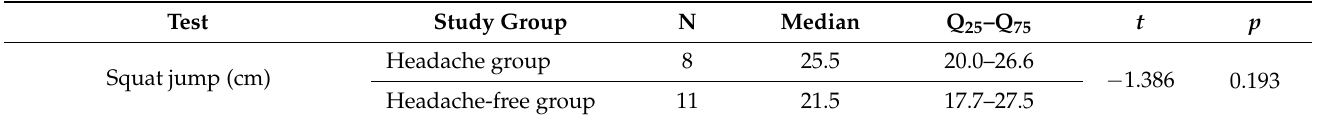
Table 2. Characteristics and differences between physical performance